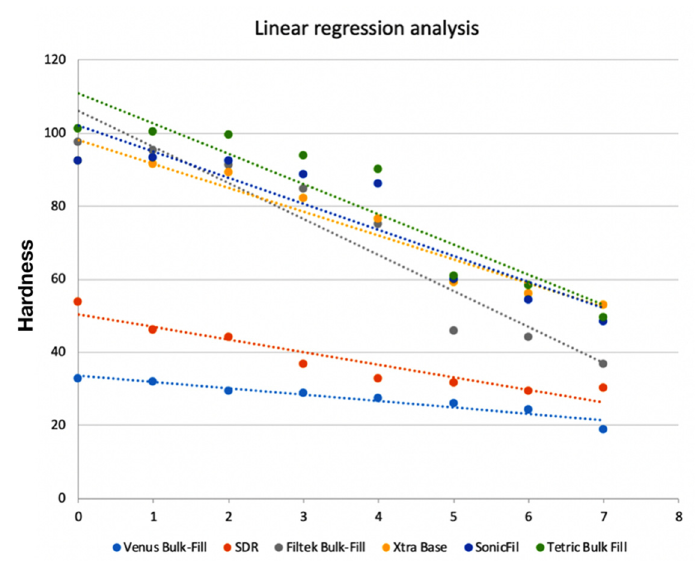
Figure 3. Linear regression of lateral MH progression of tested bulk-fill materials.